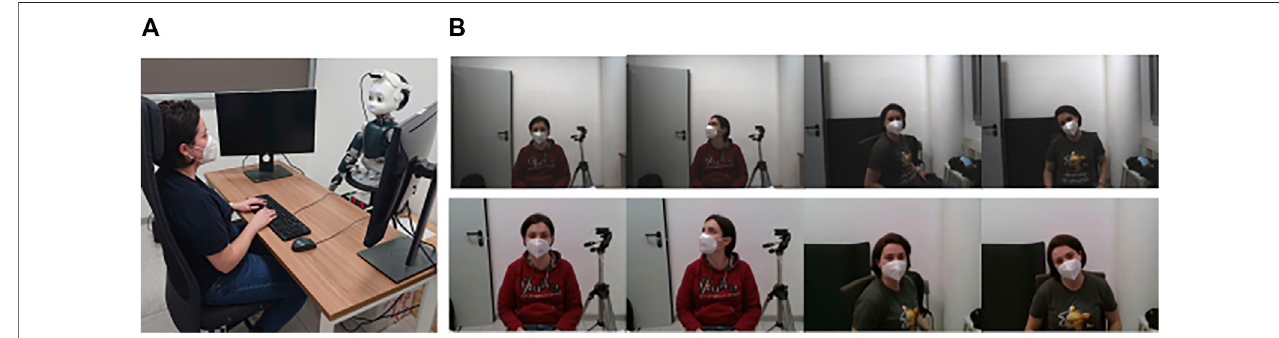
FIGURE 1 | Dataset collection. (A) Overall setup. The participant was seated at a desk in front of iCub. The latter was mounted with a RealSense camera on its head. (B) SampleframeswererecordedusingbothiCub ’ scamera( fi rstrow)andtheRealSensecamera(secondrow).Differentframescapturedifferenthumanpositions (rotation of the torso/head) and conditions (eye contact and no eye